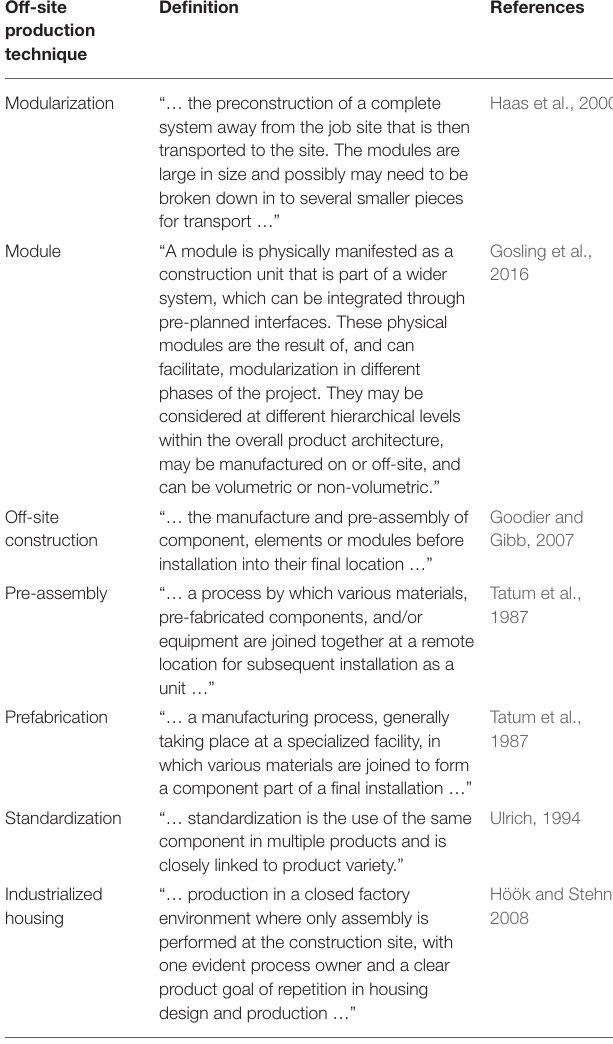
TABLE 2 | Off-site production techniques and their